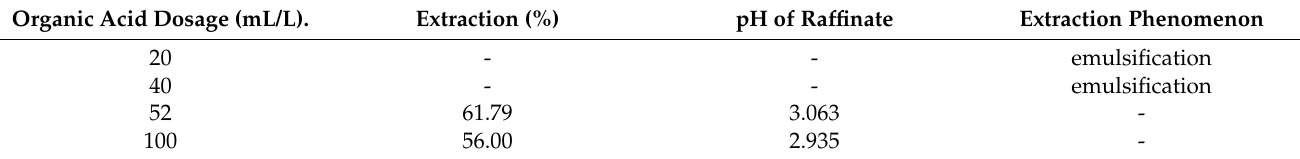
Table 4. The effect of acid dosage on zinc extraction at alkali dosage of 40 g/L. Organic Acid Dosage (mL/L).